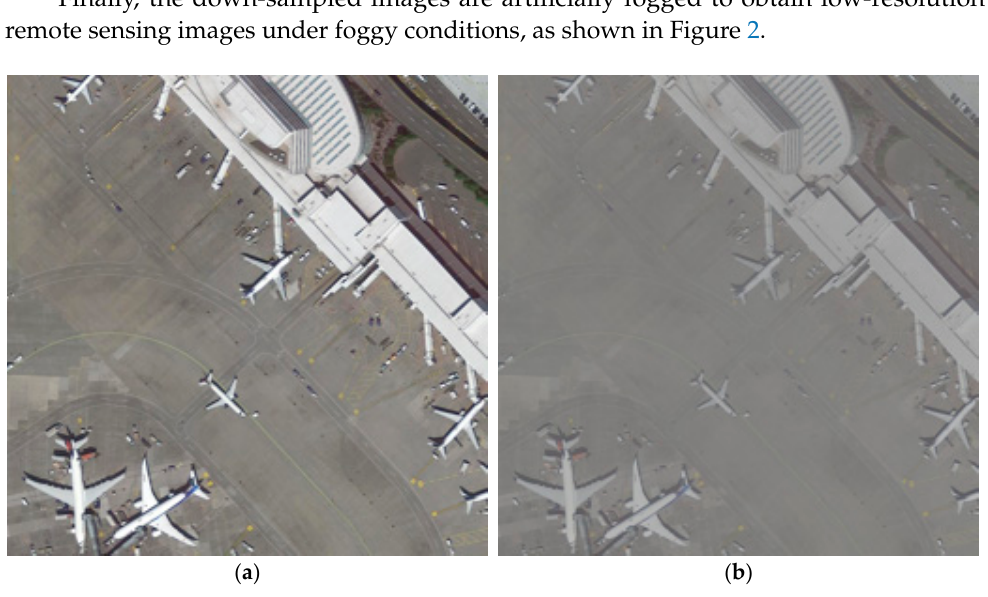
Figure 2. ( a ) The image after down-sampling; ( b ) the fogged image after down-sampling.